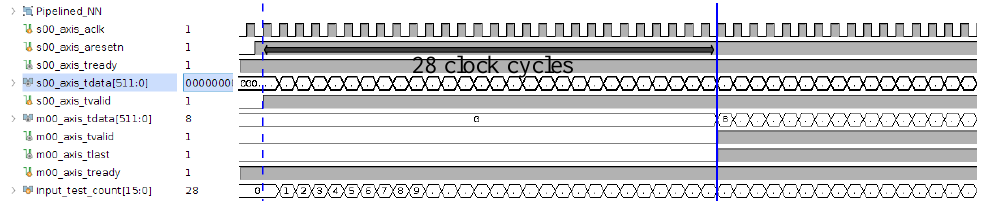
Figure 11. The wareform simulation results from the NN on FPGA using a Verilog